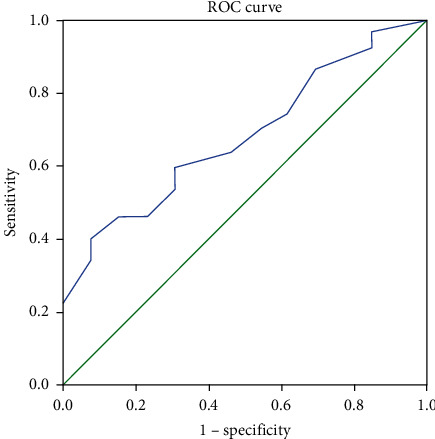
ROC curve for correlation between FFA in CSF and mortality. Diagonal segments are produced by ties.